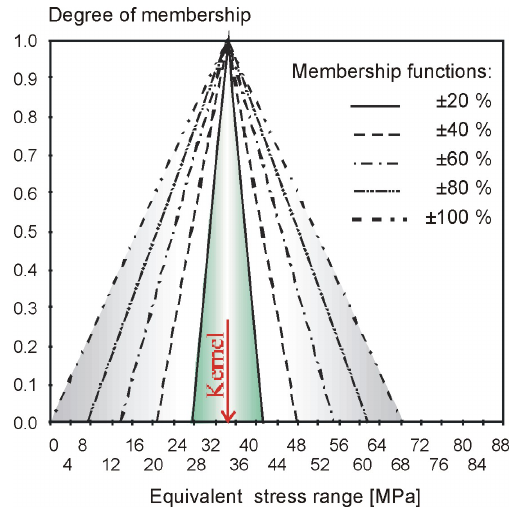
Fig. 7. Fuzzy numbers of equivalent stress